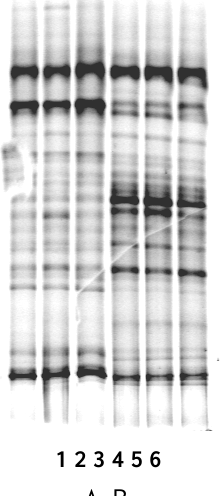
Figure 1. Variation within stool sample. DGGE profiles (V6-V8) region of two stool samples (A and B) in the front of the fecal pellet (Lanes 1 and 4), the back (lanes 2 and 5) and a homogenized sample (lanes 3 and 6). DGGE was performed on an 8% [wt/vol] acrylamide gel with a gradient from 40% at the top to 50% at the bottom at a temperature of 60 °C. 100% denaturing conditions were defined as 7M urea and 40% formamide. Gels were run for 16 h at 65 V and stained with Cyber Green. Gels were scanned in using Quantity One (Biorad) and analyzed using Diversity Database software